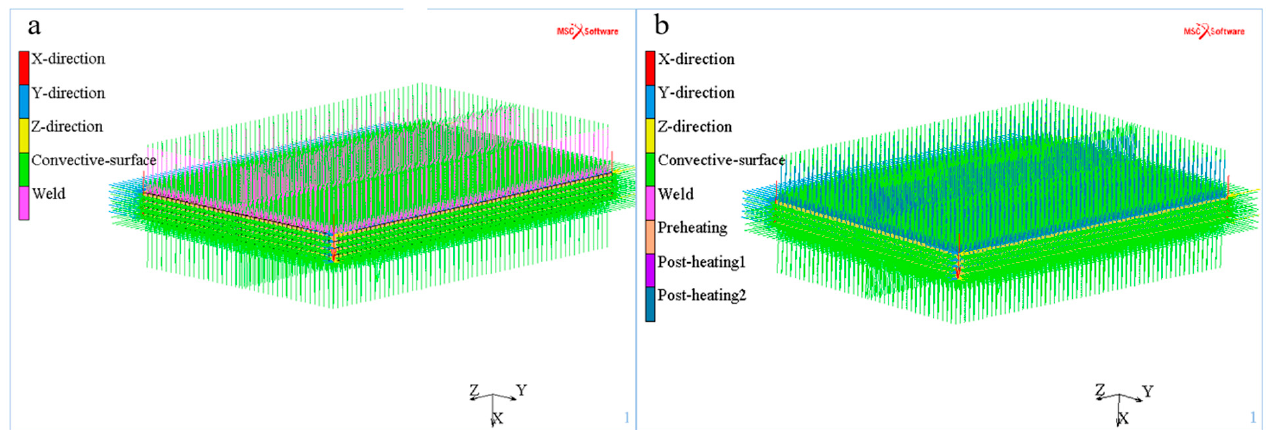
Figure 7. Boundary conditions of finite element model. ( a ) one time welding, ( b ) pre-heating, welding, and post-heating.